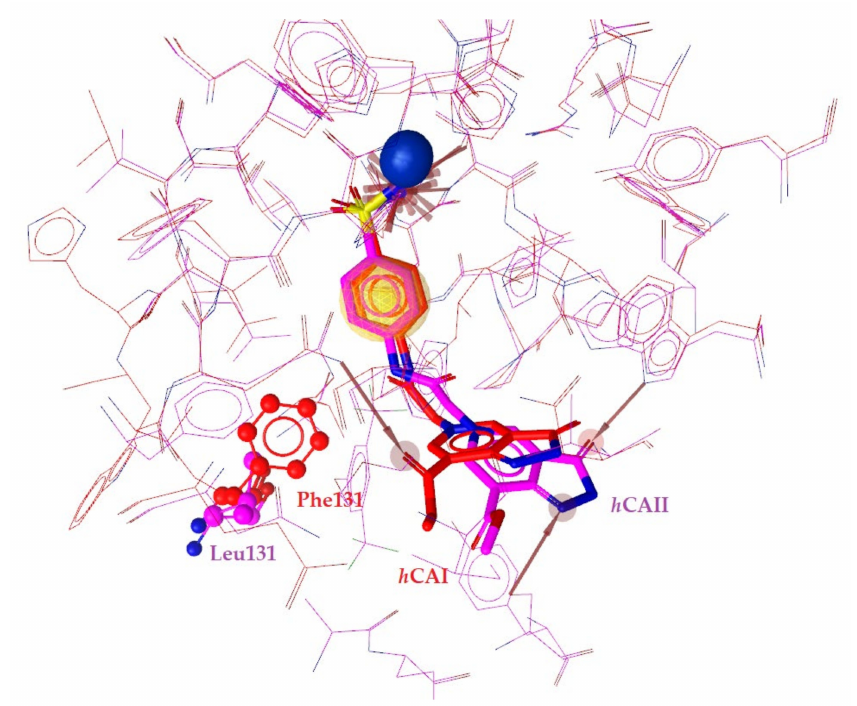
Figure 5. Superposition of compound 1f bound to hCA I (red) in comparison to hCA II (magenta), with specific residues labeled. Active-site zinc shown as blue sphere, red dotted and green arrows indicate H-bonds, and yellow spheres are hydrophobic